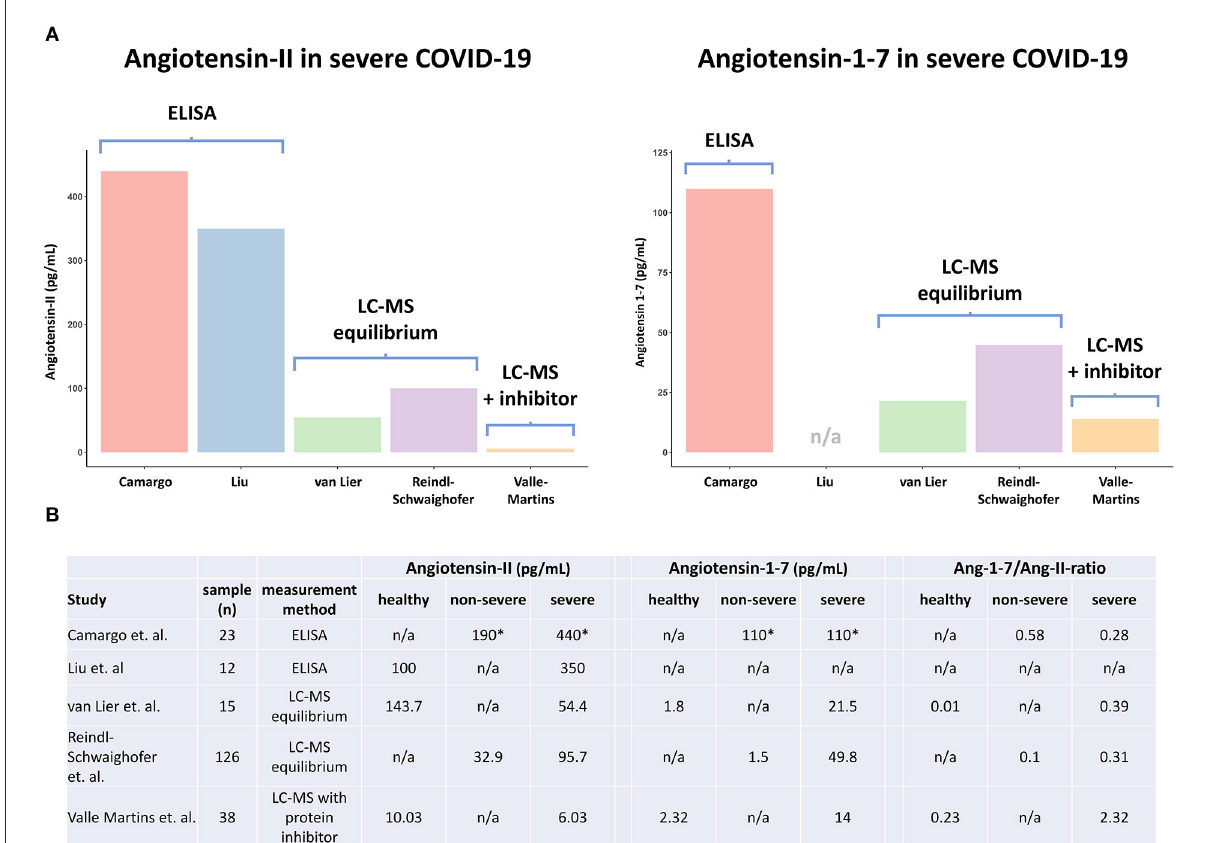
FIGURE1 Overview of angiotensin metabolite measurements in COVID-19 patients and healthy volunteers in different studies. ELISA, enzyme-linked immunoassay; LC-MS, liquid chromatography–mass spectrometry; LC-MS equilibrium, measurement method without protein inhibitor cocktail, that assesses RAAS enzymes in the circulatory compartment; LC-MS with inhibitor cocktail, measurement method that assesses true circulating levels of metabolites by direct inhibition of enzymes during sample withdrawal; Ang-1–7/Ang-II-ratio, Angiotensin-1-7 Angiotensin-II ratio. *Exact levels of angiotensin metabolites were not reported by Camargo et al., and were thus inferred from the